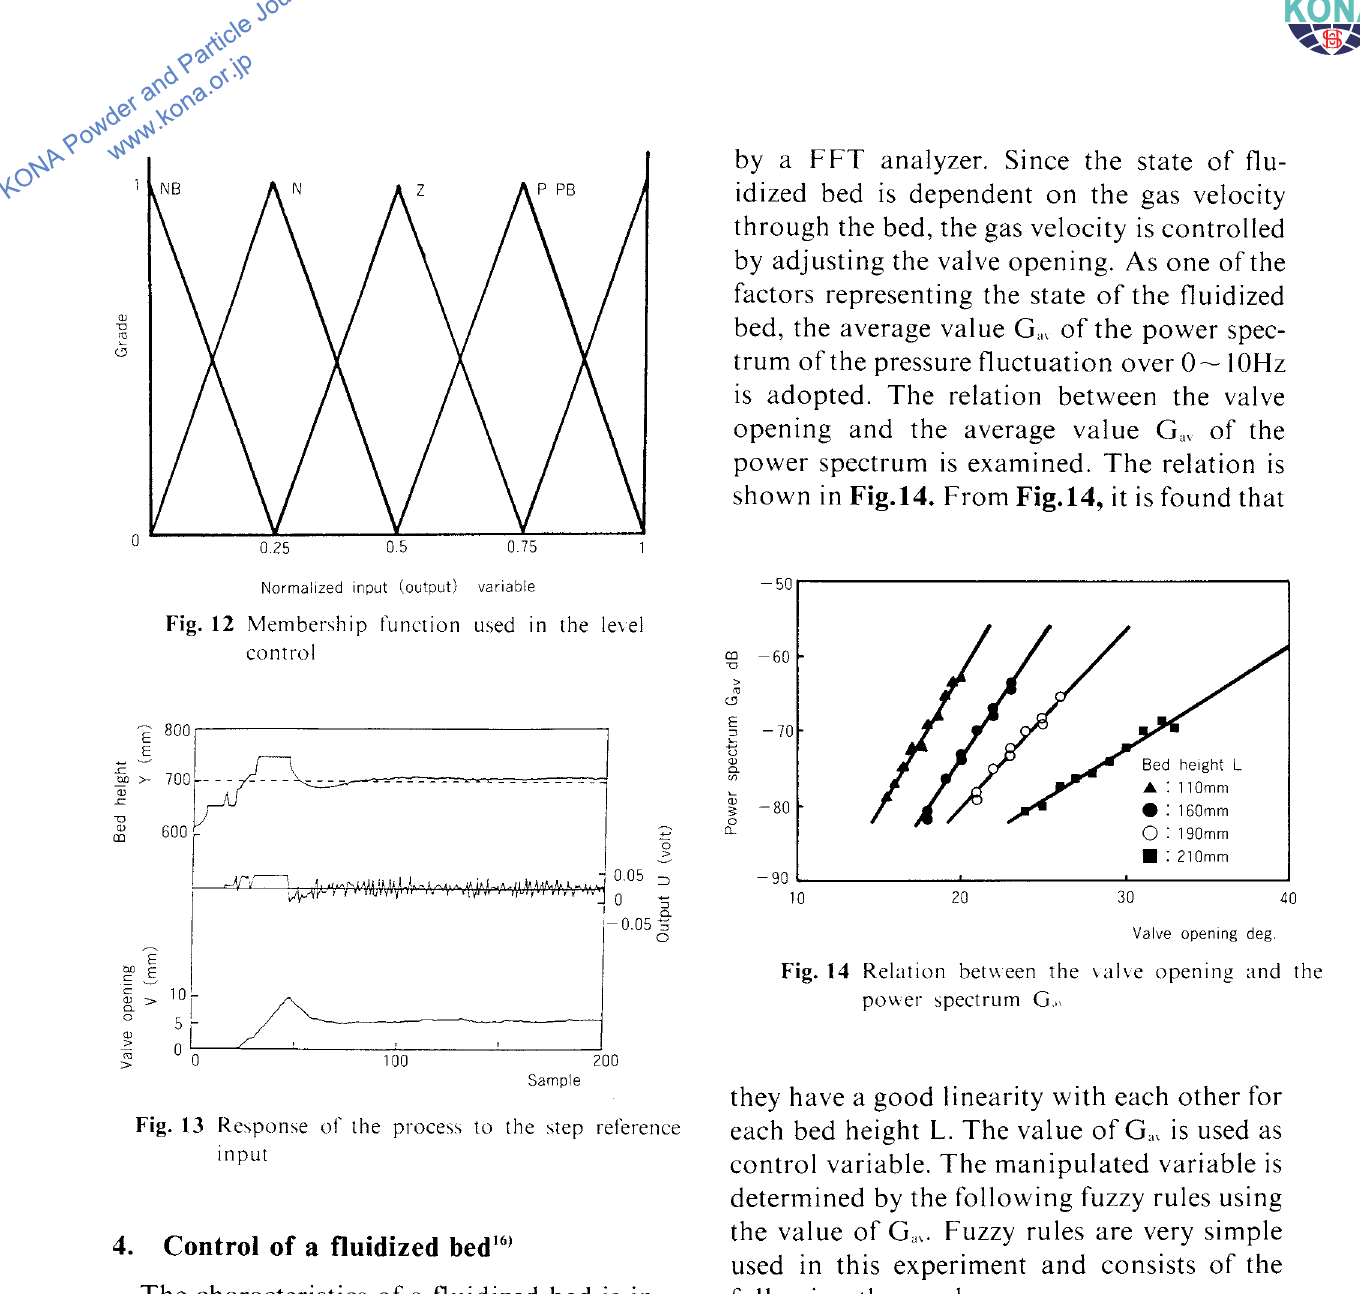
Fig. 14 Relation bet\\een the \al\e opening and the po\\er spectrum